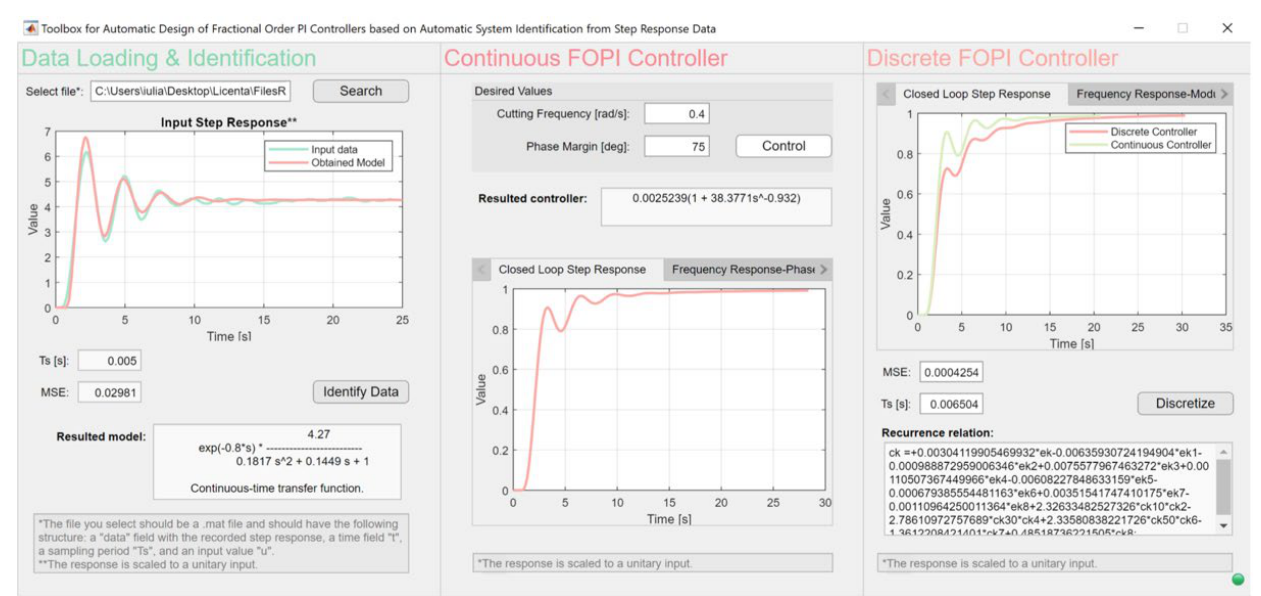
Figure 6. Result of the AFOPI toolbox for the case study.